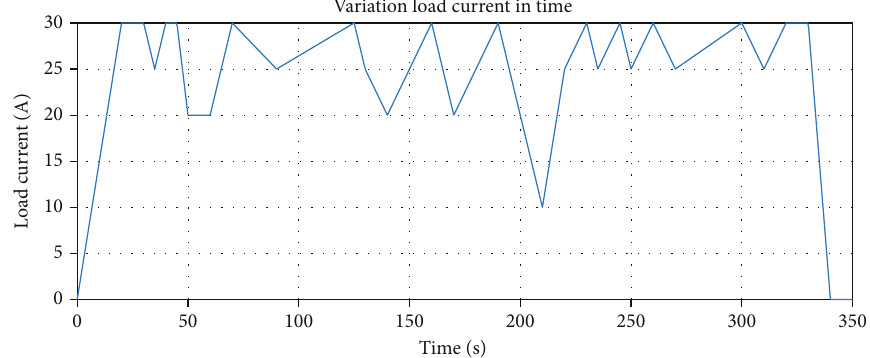
Figure 12: Load pro fi le used in numerical simulations — case I.